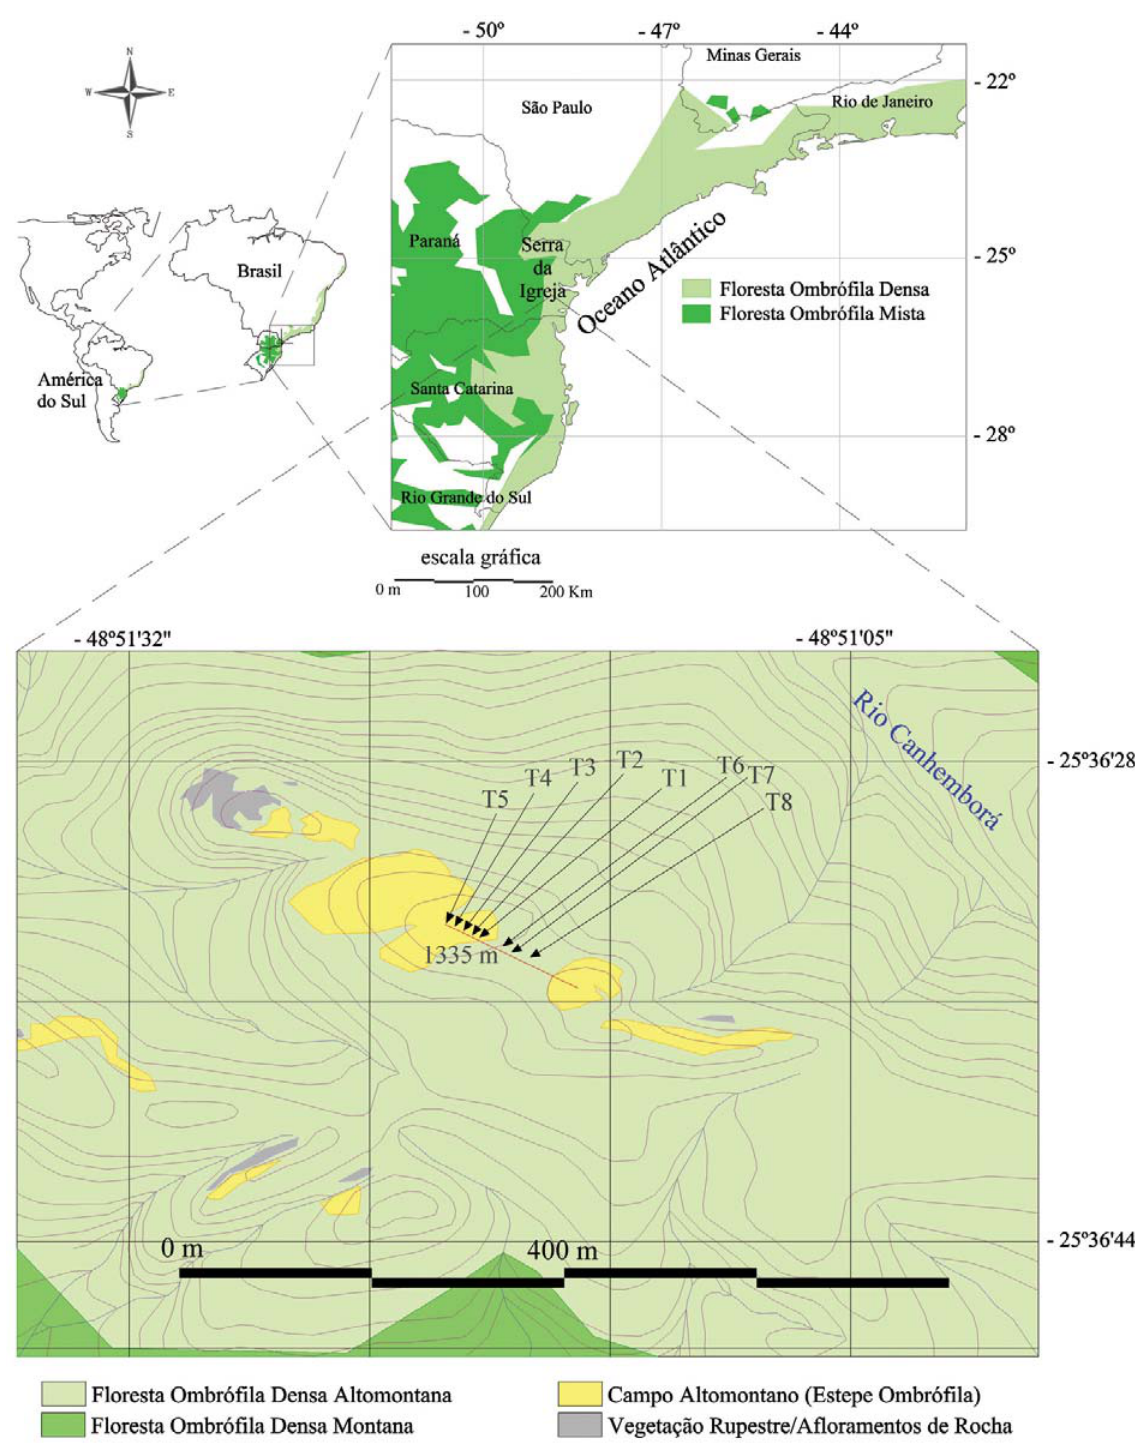
Figura 1. Localização da sequência amostral na Serra da Igreja,